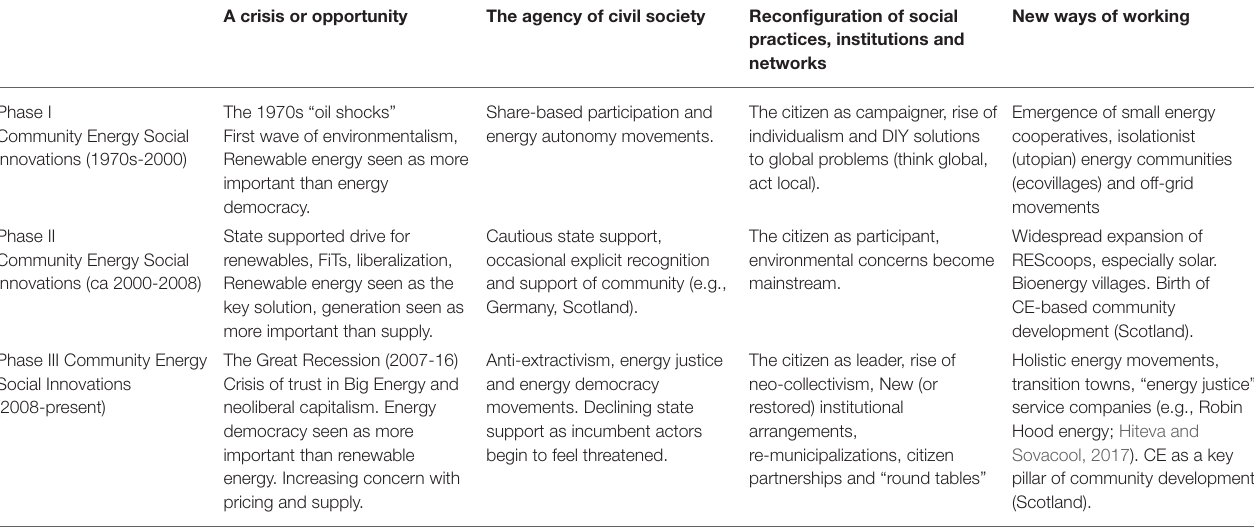
TABLE 3 | Three waves of social innovation in community energy in